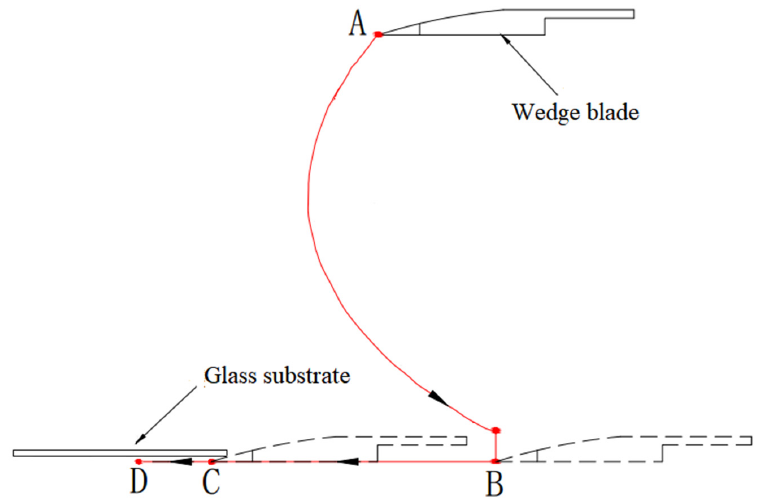
Figure 2. Schematic diagram of glass substrate peeling process.